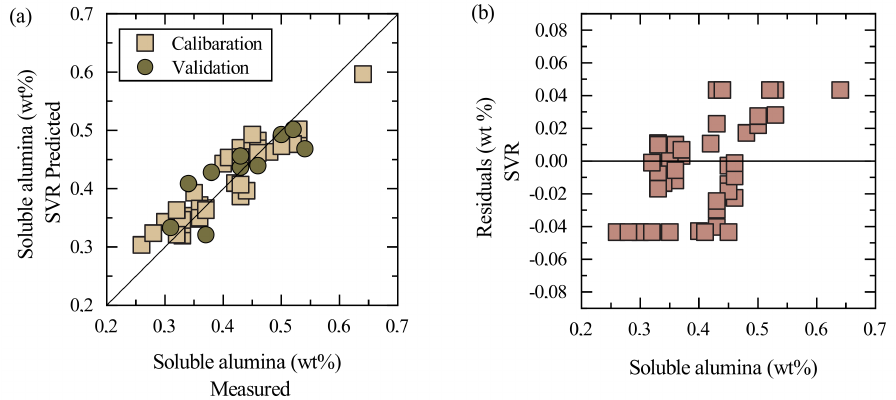
Figure 3. ( a ) Measured vs Predicted plot of the original SVR model in the calibration and validation samples and ( b ) their respective residuals. Reproduced after Guatame-García and Buxton [6].